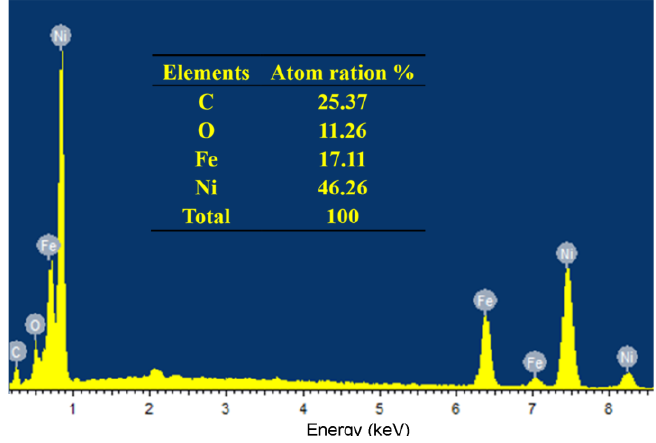
Figure 5. Energy-dispersive X-ray (EDX) spectrum of MW–18 wt